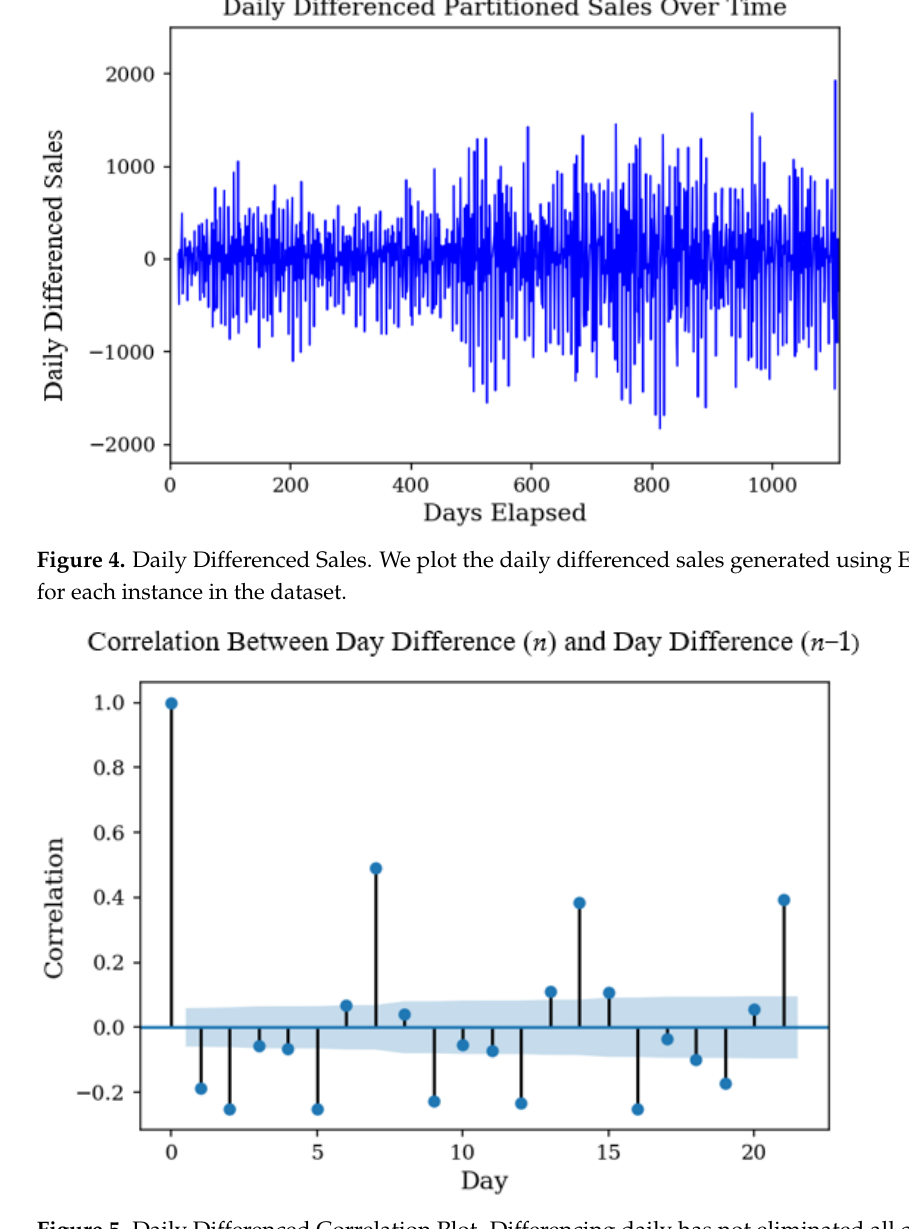
Figure 5. Daily Differenced Correlation Plot. Differencing daily has not eliminated all correlations between days, and a negative correlation is introduced. We aim to see in testing if features are more linearly separated.